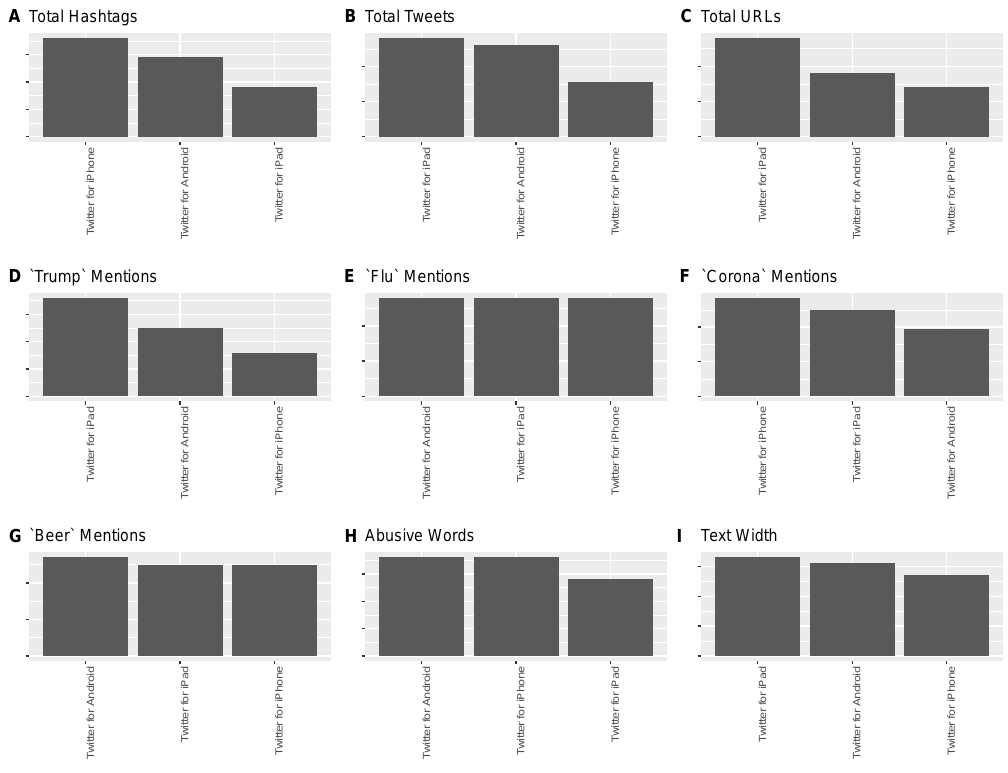
Figure 6. Source device comparison by relative